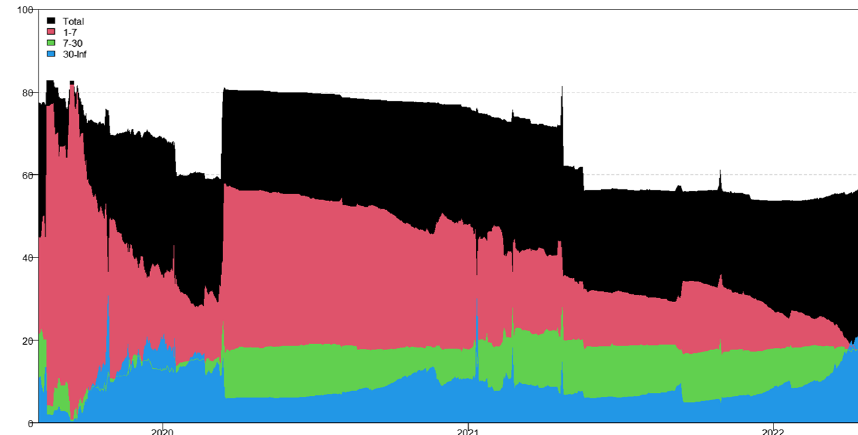
Fig. 8 Dynamic total connectedness—realized volatility (RV)